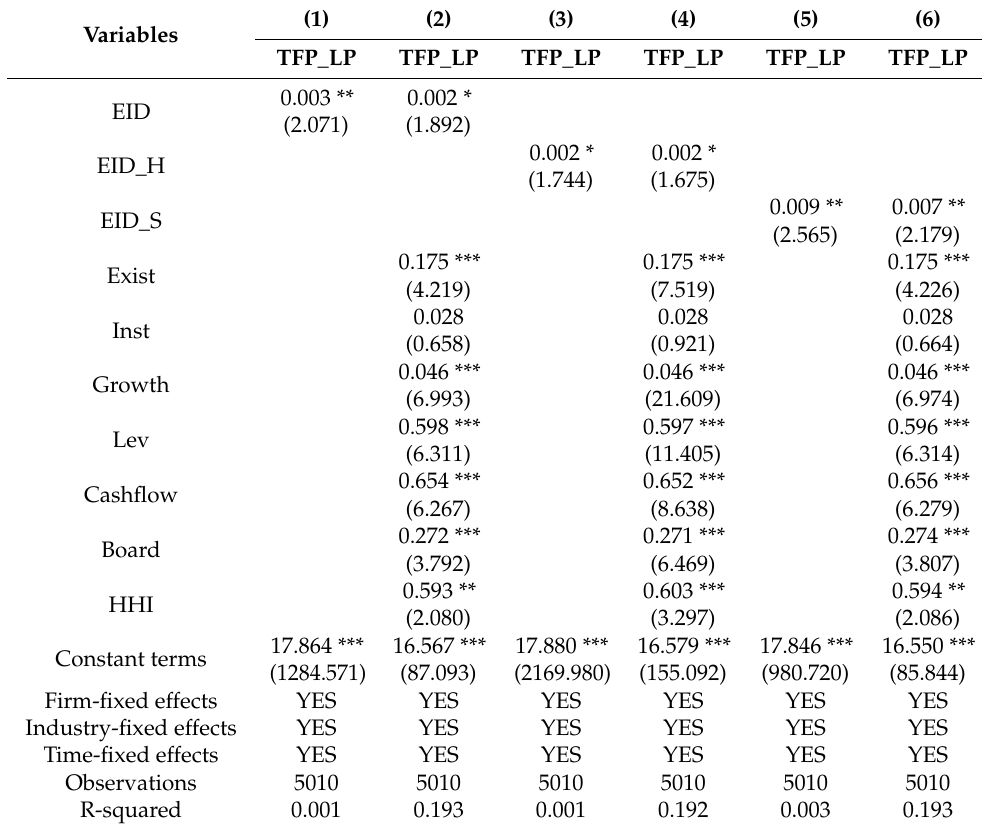
Table 2. Regression benchmark